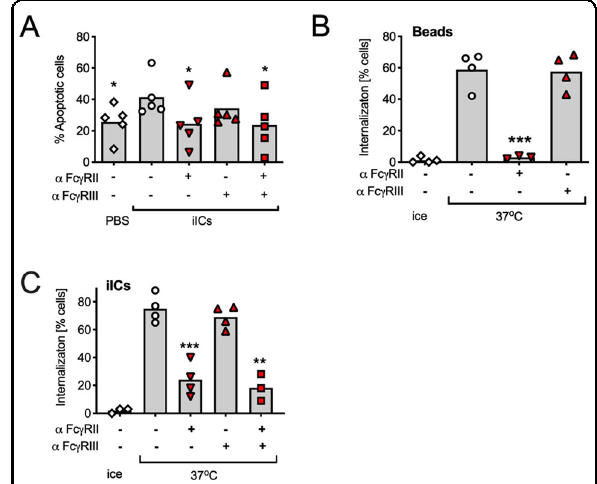
Fig. 5 Fc γ R dependency of iIC-induced neutrophil apoptosis and iIC internalization. A Following incubation on ice with Fc γ R blocking antibodies (3G8, IV.3) or vehicle as indicated neutrophils were stimulated with 10 μ g/ml iICs for analysis of neutrophil apoptosis after 12 h. Internalization of beads ( B ) and iICs ( C ) by neutrophils that had been incubated with blocking antibodies (3G8, AT10) or vehicle as indicated. Each symbol represents the average value obtained in a separate experiment. Data were subjected to analysis by one-way ANOVA with multiple comparisons post-hoc test; * p < 0.05; ** p < 0.01; ** *p <